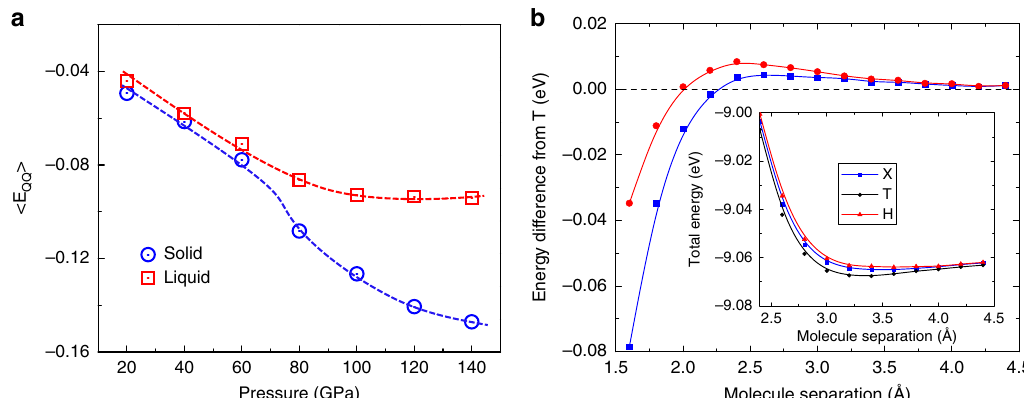
Fig. 5 Local hydrogen molecule arrangement of solid and liquid phases. a The contribution of the fp _ E QQ fi ngerprint in solid and liquid. Data were obtained as a time average of single-phase calculations the solid – liquid phase boundary. b DFT calculations of the interaction between two hydrogen molecules as a function of distance for three orientations. In the DFT calculations the separation vector lies along the z -axis, and one of the molecules to point along x ; H, X, and T represent the second molecule pointing along x , y, and z, respectively. The con fi guration with both pointing along z is always unfavourable. Main fi gure: energy differences relative to T , Inset: total energy relative to free